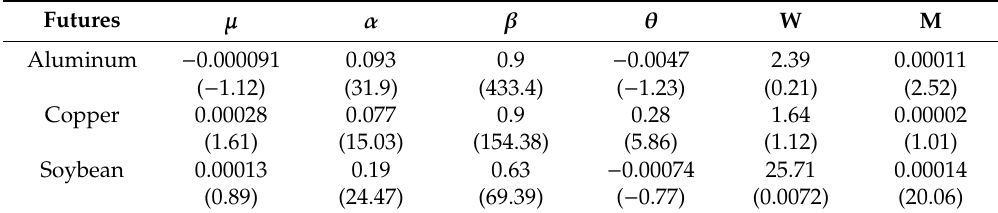
Table 10. Parameter estimates of one-side GARCH-MIDAS model with interest